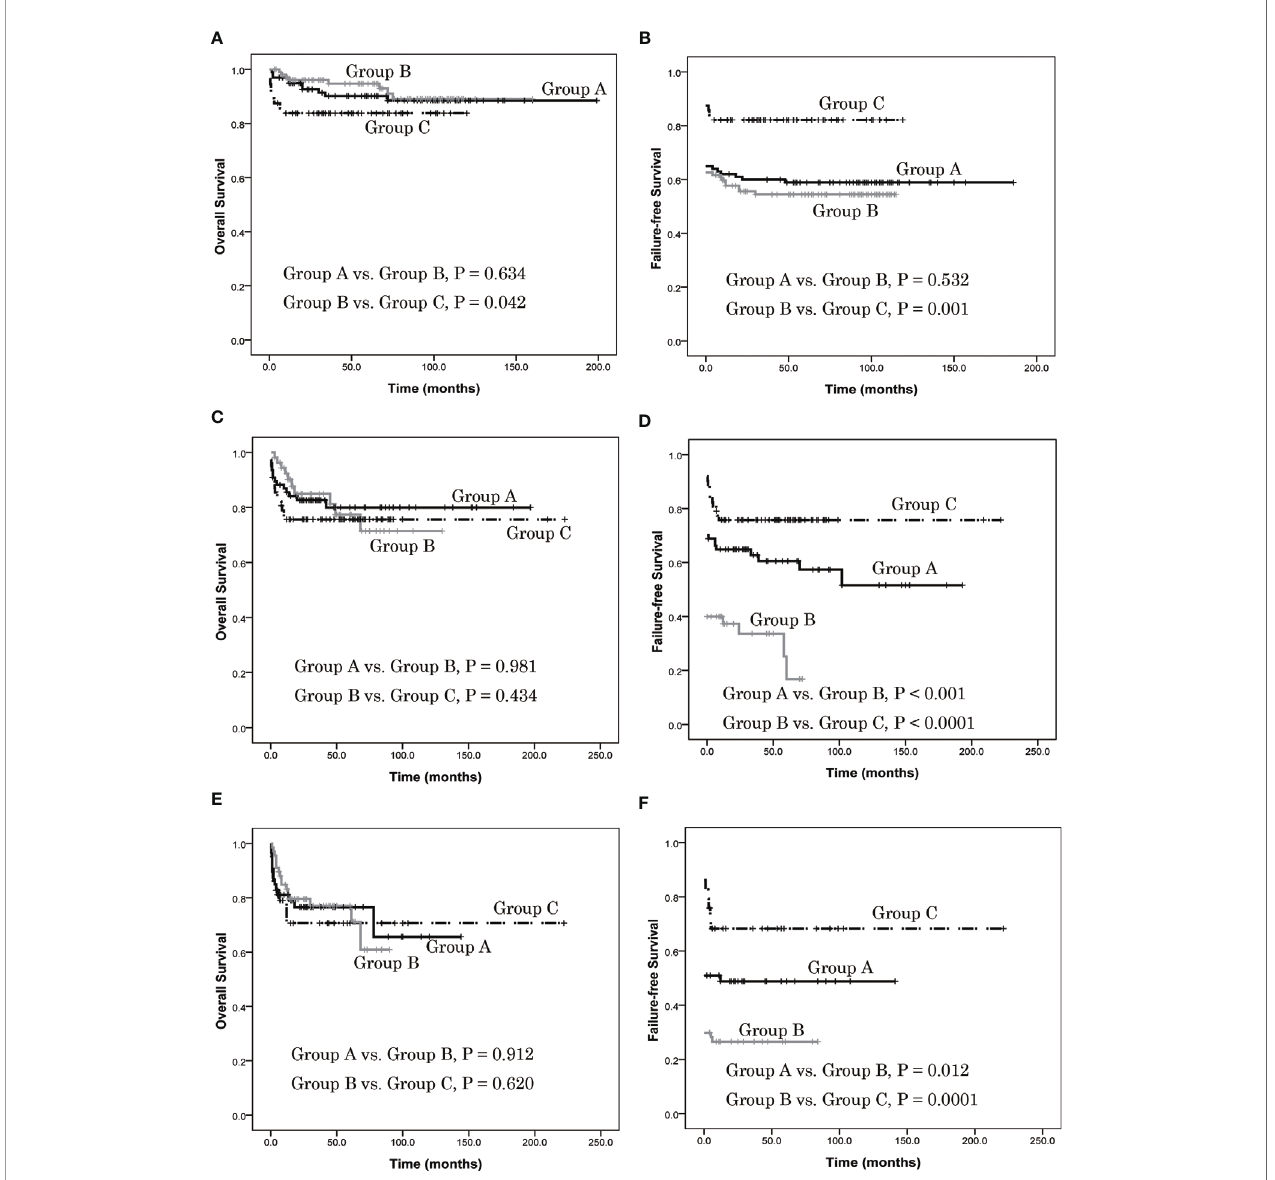
FIGURE 3 | Overall survival (OS) and failure-free survival (FFS) of patients with different age group, as assessed using Kaplan-Meier analysis. (A) In patients ≤ 20 years of age, there was no difference in estimated 5-year OS between group A and group B (90.2% ± 3.1% vs . 94.7% ± 2.3%, P = 0.634), but it was higher in group B than in group C (94.7% ± 2.3% vs . 83.9% ± 4.9%, P = 0.042). (B) There was no difference in estimated 5-year FFS between group A and group B (58.4% ± 4.9% vs . 54.4% ± 4.9%, P = 0.532), but it was lower in group B than in group C (54.4% ± 4.9% vs . 82.1% ± 5.1%, P = 0.001). (C) In patients 21 – 39 years of age, there was no difference of estimated 5-year OS between groups A and B (80.0% ± 5.0% vs . 77.4% ± 7.1%, P = 0.987), or between B and C (77.4% ± 7.1% vs . 75.7% ± 5.5%, P = 0.434). (D) The estimated 5-year FFS of group A was higher than group B (60.5% ± 5.9% vs . 16.8% ± 9.1%, P < 0.001) as was group C (75.7% ± 5.5% vs . 16.8% ± 9.1%, P < 0.0001). (E) In patients ≥ 40 years old, there was no difference of estimated 5-year OS between groups A and B (76.5% ± 6.0% vs . 77.0% ± 5.5%, P = 0.912), or between groups B and C (77.0% ± 5.5% vs . 70.7% ± 8.8%, P = 0.620). (F) The estimated 5-year FFS of group A was higher than group B (48.8% ± 6.9% vs . 26.5% ± 5.4%, P = 0.012) as was group C (68.3% ± 8.8% vs . 26.5% ± 5.4%, P =